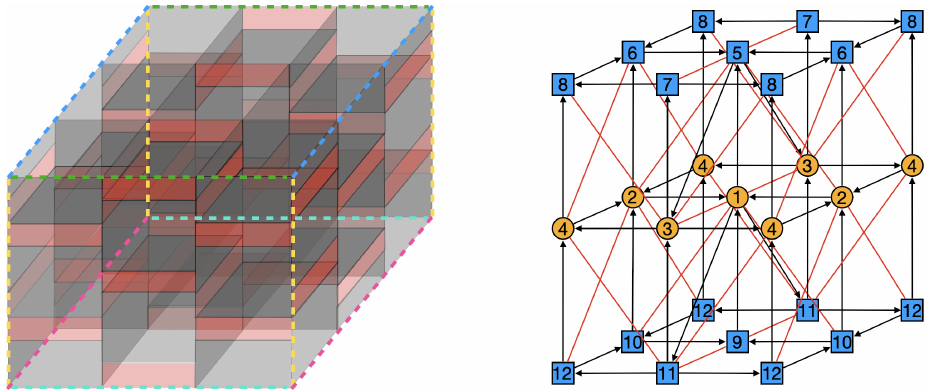
Figure 26 . BFT 2 defined on T 2 × I and its dual quiver. We have included colored dotted lines to emphasize the T 2 identifications on the horizontal